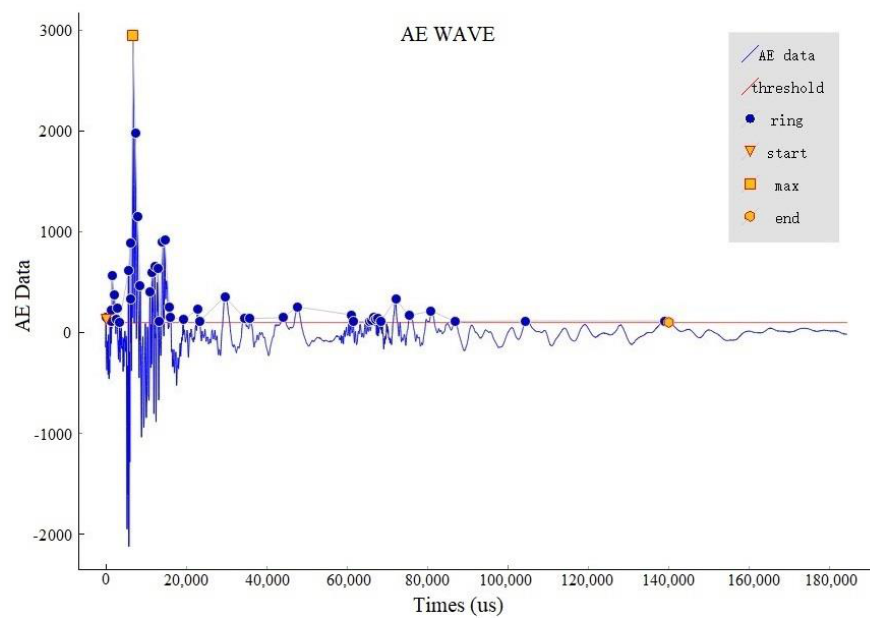
Figure 4. AE data collection curve.